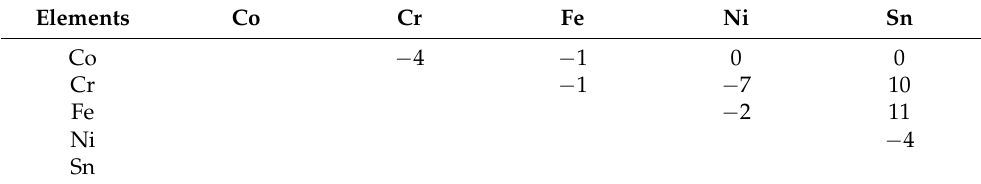
Table 2. The Δ H mix,<ij> values (kJ/mol) of CrFeCoNi and CrFeCoNiSn alloys [data from 27]. Table 2. The ∆ H mix,<ij> values (kJ/mol) of CrFeCoNi and CrFeCoNiSn alloys data from [27].